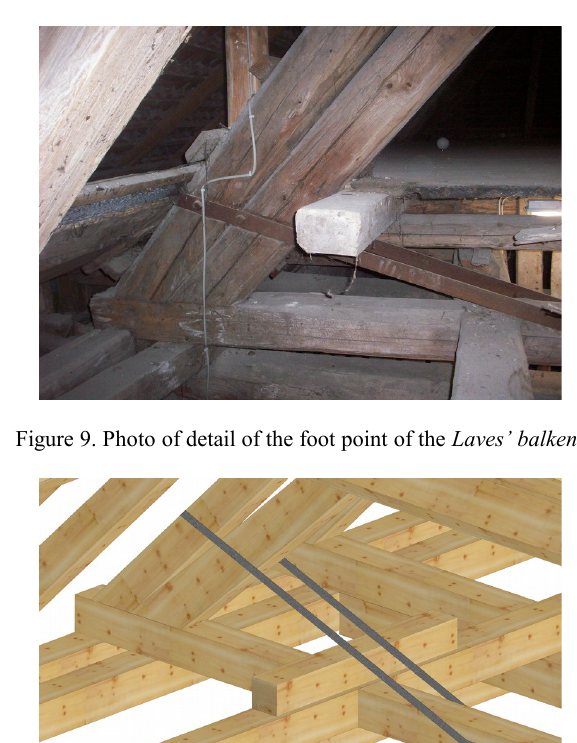
Figure 8. CAD transversal section of the pagoda.